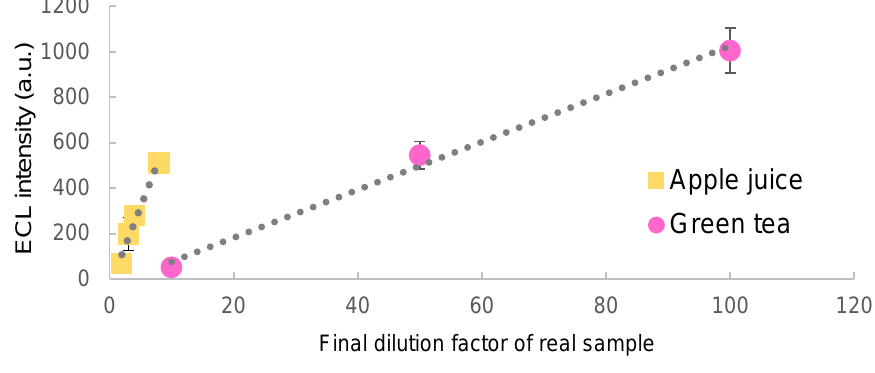
Figure 5. ECL quenching effect of real beverage